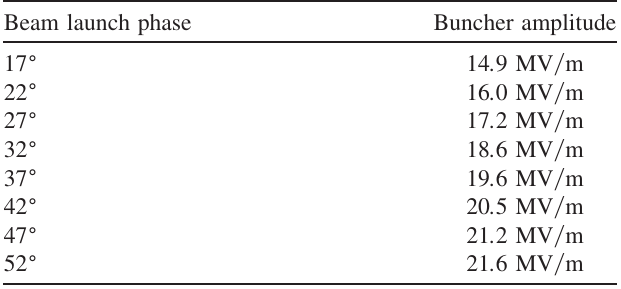
FIG. 16. Beam arrival time and beam energy variation caused by gun phase and amplitude error. An rf error, 0.014 (cid:3) phase or 0.013% amplitude, was assumed to take place at the gun. The buncher was assumed to operate at the nominal phase and amplitude condition without jitter. At the nominal launch phase, 37 (cid:3) , beam arrival time variation at 0.45 m to rf phase error (red filled circle) comes with beam energy variation (red nonfilled circle). When the beam passes through the buncher, the beam energy variation is reversed and the beam arrival time variation is compensated by about 50%. On the contrary, arrival time varia- tion to rf amplitude error (blue filled square) is less compensated by the buncher because the beam energy change (blue nonfilled square) in the buncher is not sufficient. See the text for more discussion.